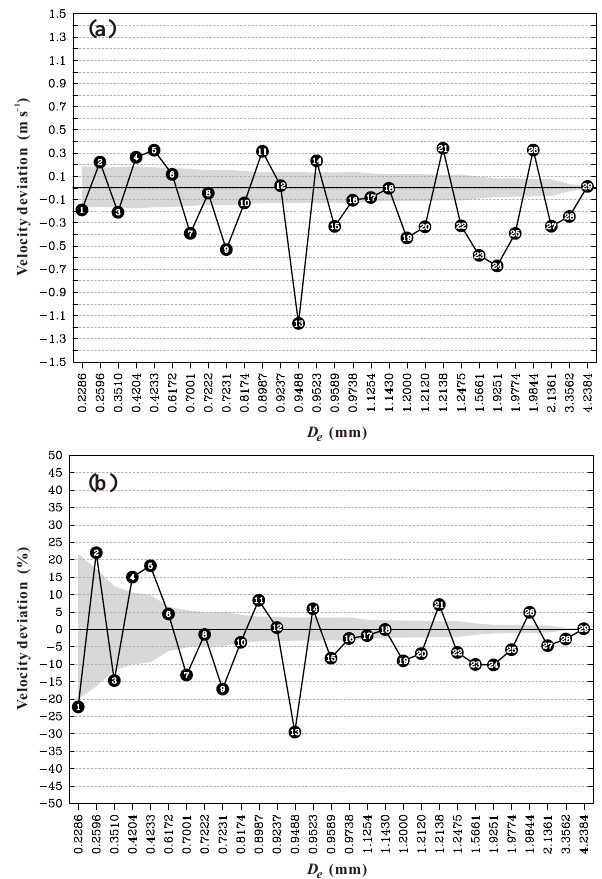
Figure 11. As in Fig. 7 but showing V e values and percentiles of the HSC-observed DFSs for analyzed natural drops. For clarity and discussion, each drop has been labeled with digits from 1 to